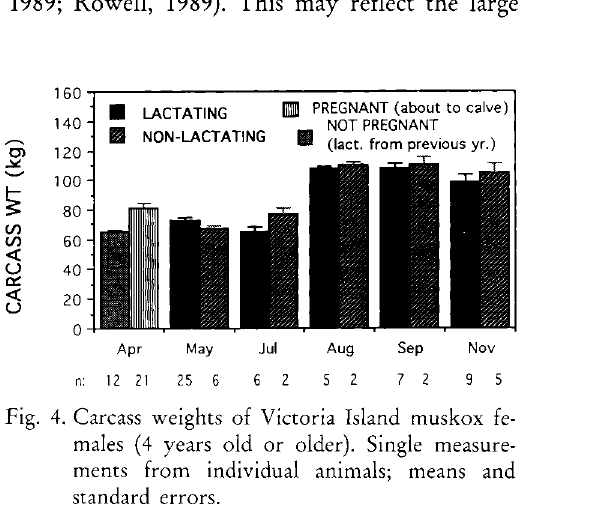
Fig. 3b. Body weights of captive muskox cows, Sa skatoon (all at least 5 years old). Repeated measurements from individual animals; means and standard errors.